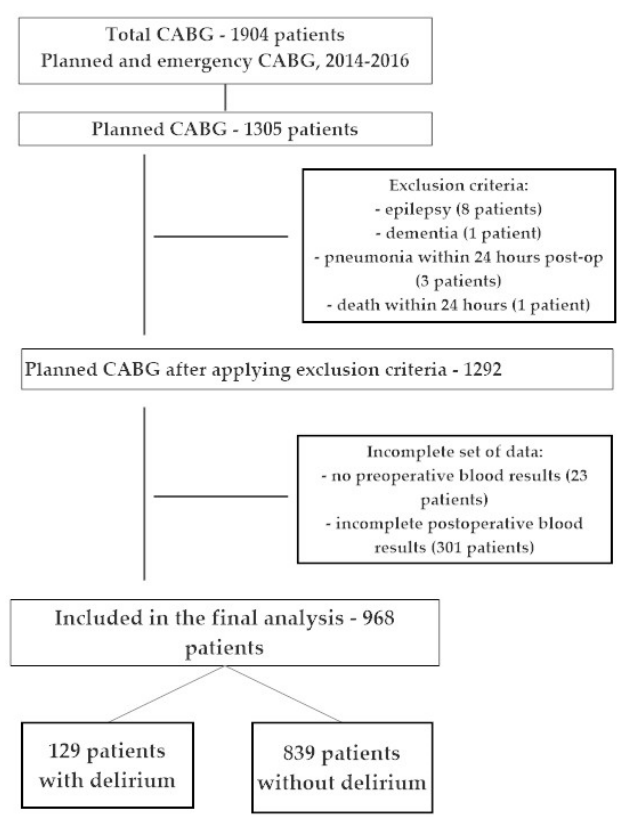
Figure 1. Study flowchart.